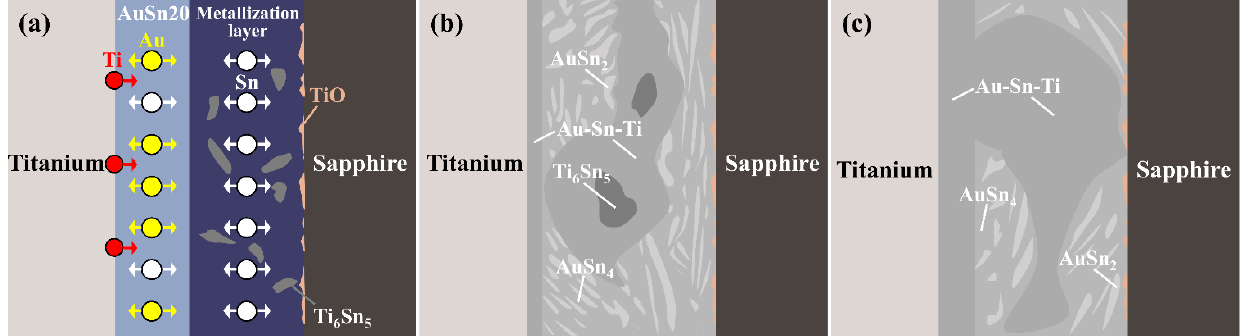
Figure 7. Schematic diagram of the microstructure evolution of titanium/AuSn20/Sn-3Ti/sapphire joint: ( a ) atomic diffusion; ( b ) formation of reaction products at 550 °C; and ( c ) interfacial structure of the brazing seam at 650 °C.